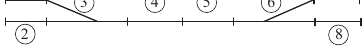
Figure 1. Simple railway